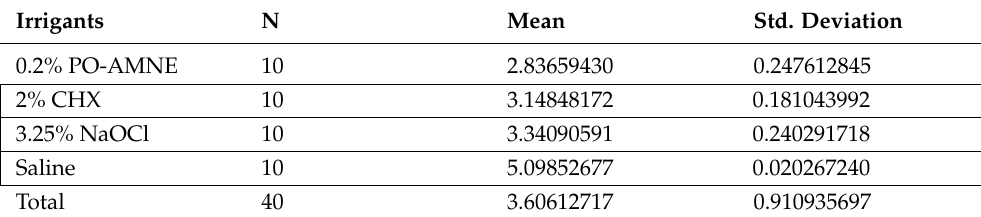
Table 11. Mean and standard deviation of irrigants against C. albicans at 200 µ m. Irrigants N Mean Std.